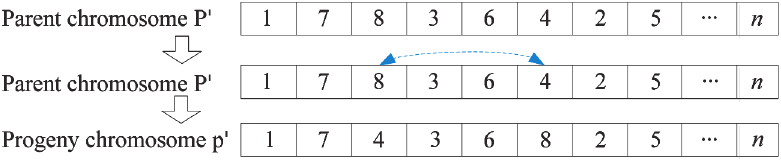
Figure 4. Detail principle of mutation